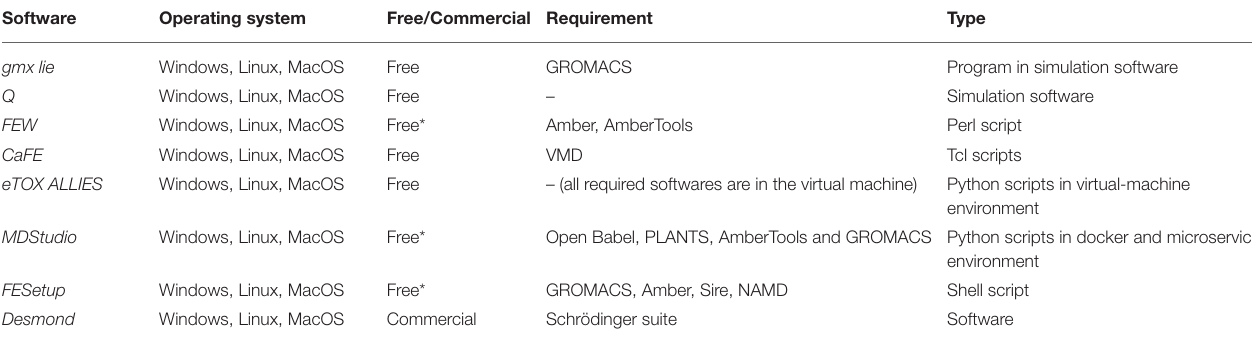
TABLE 1 | Selection of available tools to perform, facilitate and/or automate LIE calculations.